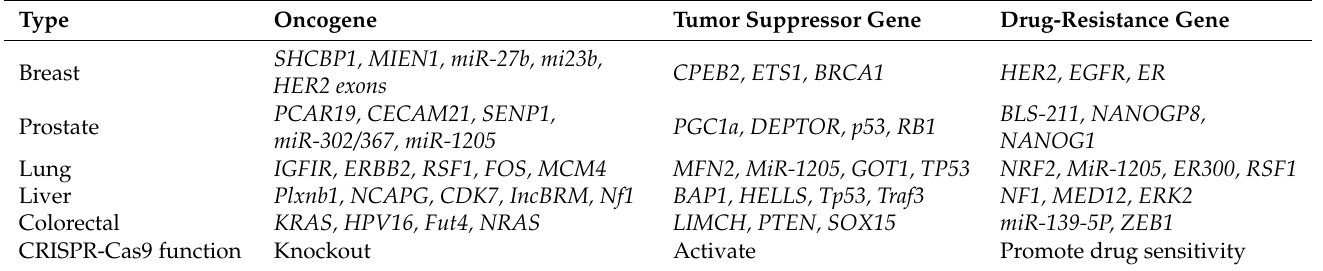
Table 3. The use of CRISPR-Cas9 system in the treatment of different types of cancer